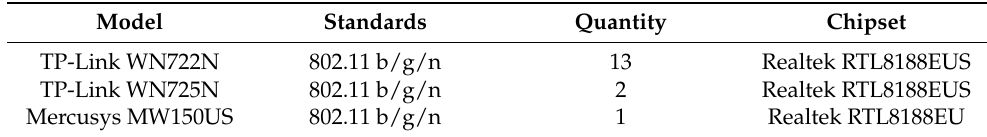
Table 1. Wi-Fi transmitters used in the